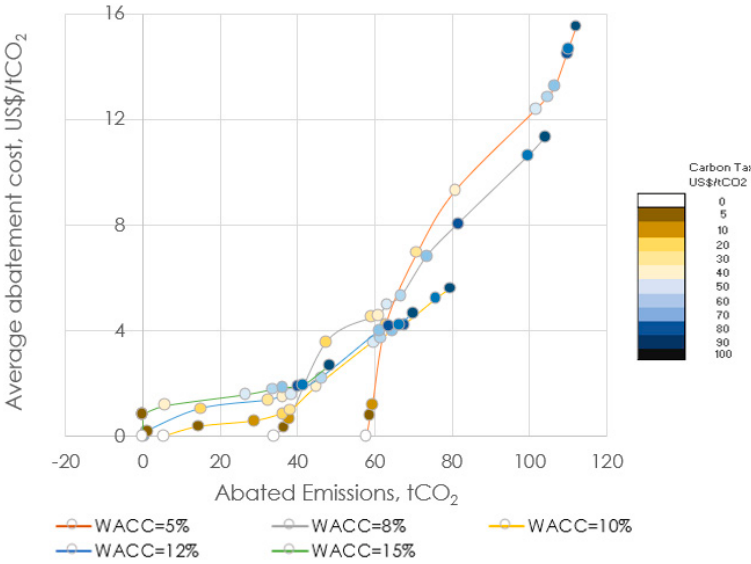
Figure 10. Average multiyear abatement costs vs abated emissions of each scenario compared to the reference scenario.